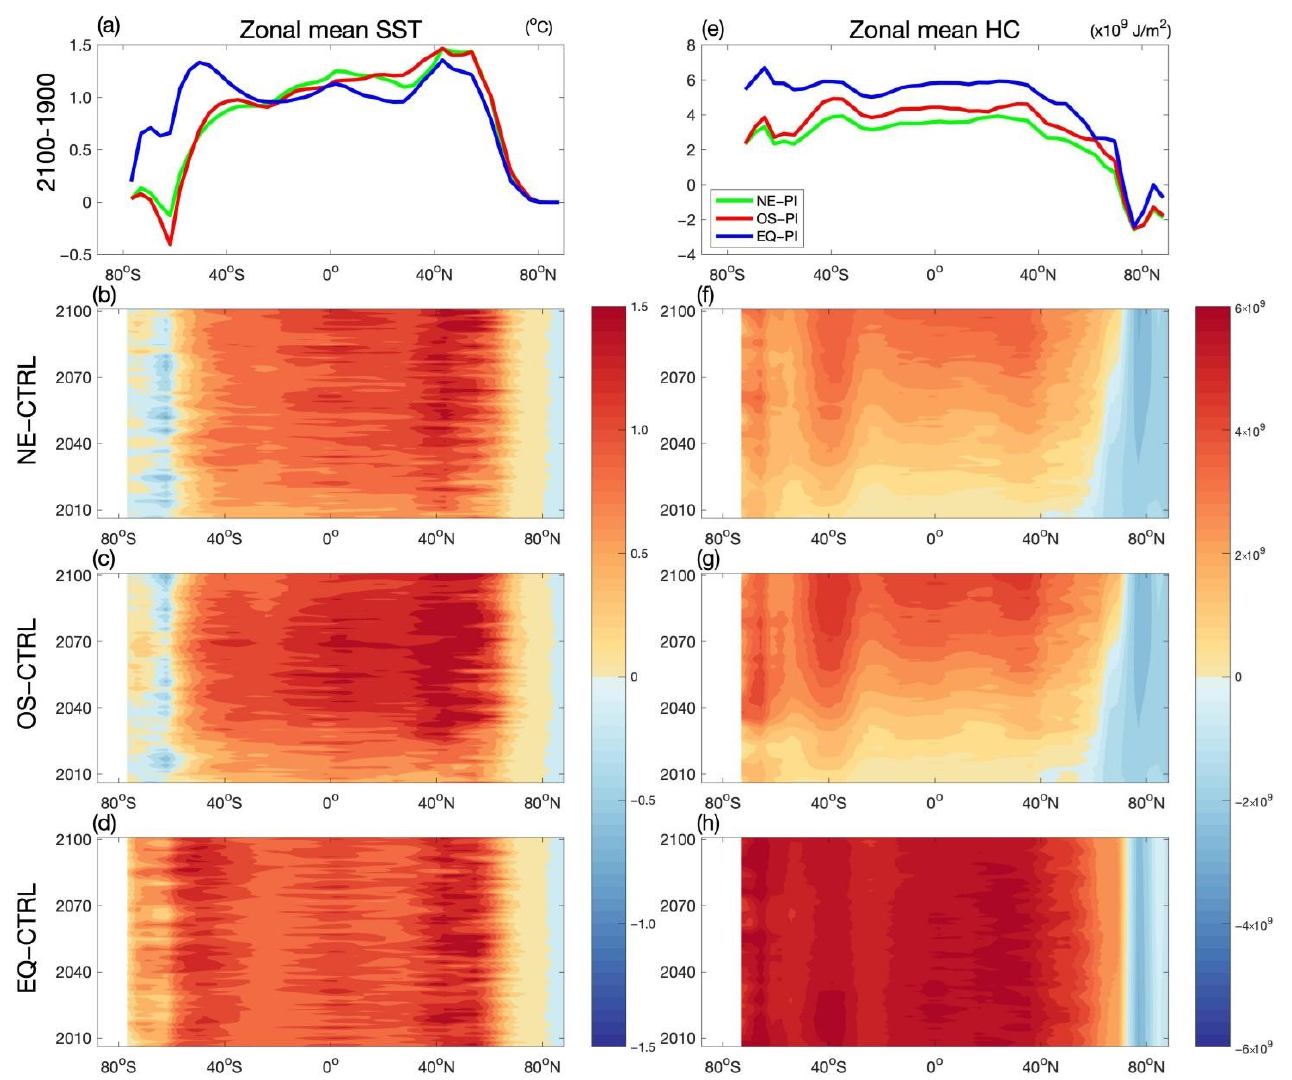
Figure 3. The sea surface temperature (SST) and ocean heat content (HC) change in the twenty-first century relative to the nineteenth century shown as zonal mean ( a , e ). The zonal mean SST and HC change each year under three global warming scenarios ( b – d , f – h ). Units are ◦ C and J/m 2 . The changes in the upper ocean heat content are quite different from those of SST, with a meridionally near uniform increase, except in the northern high latitudes, for all three warming scenarios (Figure 3e). Around 40 ◦ S, there is a peak in the change of HC, which is linked to the deeper heat storage in that region [13,34] (see also Figure 4l–n). The temporal evolution of the zonal mean SST and HC anomalies show that the zonal mean SST in the northern mid to high latitudes starts to warm first (Figure 3b,c), while the HC increases in the Southern Hemisphere first in the two transient warming scenarios (Figure 3f,g). The increase in HC in the deeper part of the Southern Ocean delays the surface warming there, and the northward transport of HC [35] may even lead to a cooling on the surface. As expected, the HC in the EQ case does not change with time (Figure